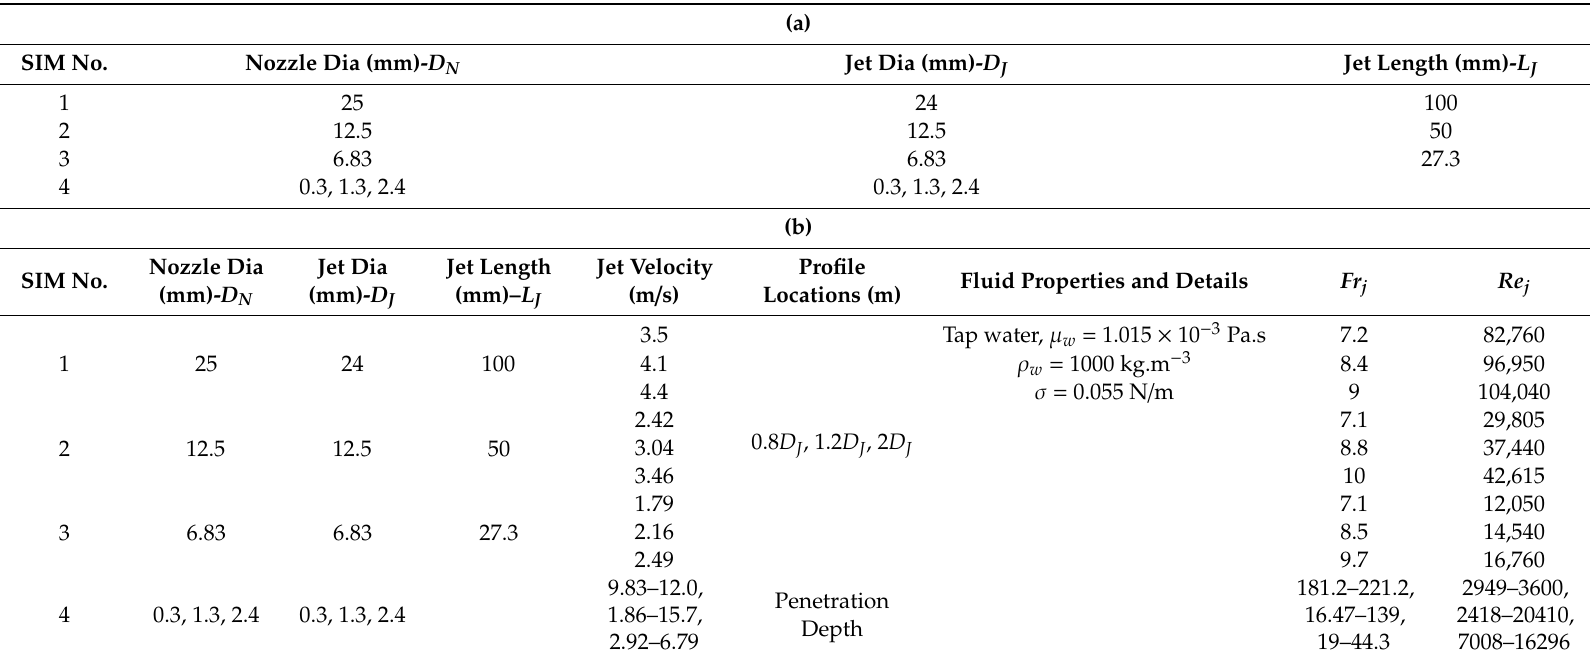
Table 3. ( a ) Geometry of Plunging Liquid Jet. ( b ) Operating Conditions and Fluid